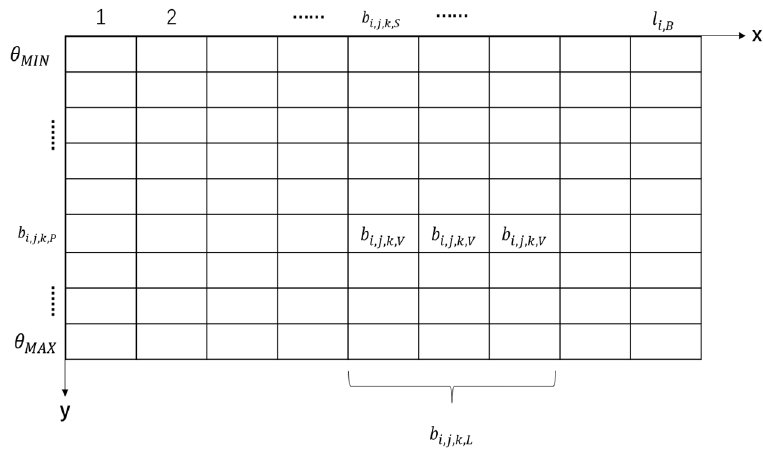
Figure 5. Bar encoding. Figure 5. Bar